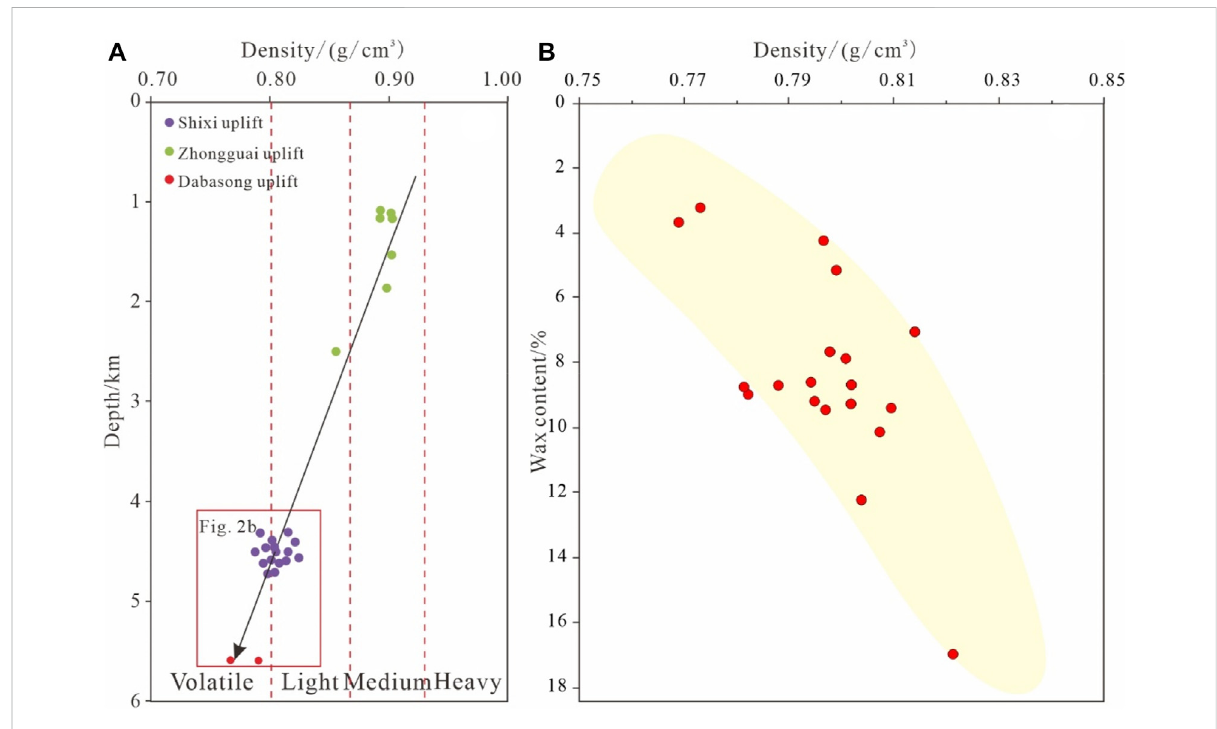
FIGURE 2 Oil density versus (A) depth and (B) wax content for Carboniferous crude oils in the Penyijingxi